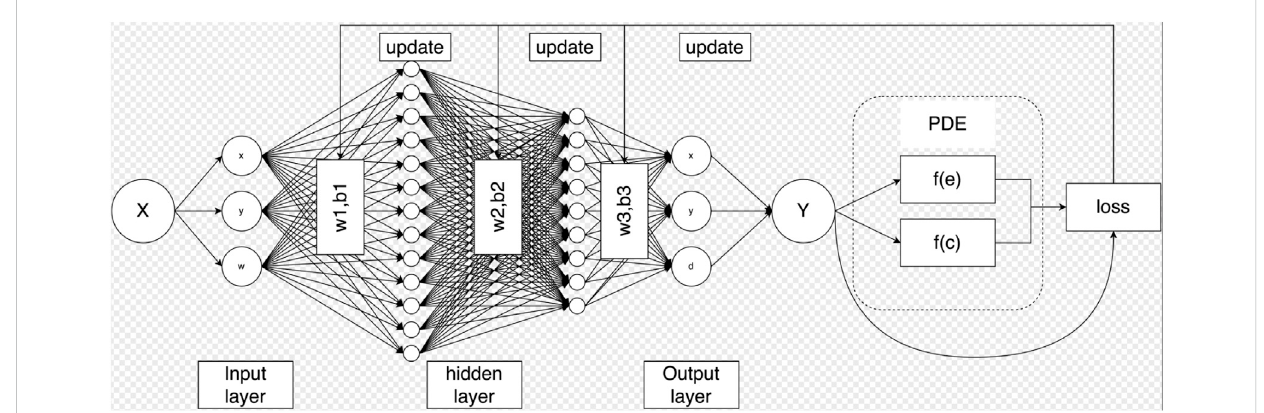
FIGURE 2 Schematicrepresentationoftheproposedphysicsinformedneuralnetwork.Xrepresentstheinputoftheneuralnetwork,Yrepresentstheoutputof the neural network, f(e) represents the elastic strain energy, and f(c) represents the fracture energy. For training, we have used the ADAM optimizer followed by L-BFGS.